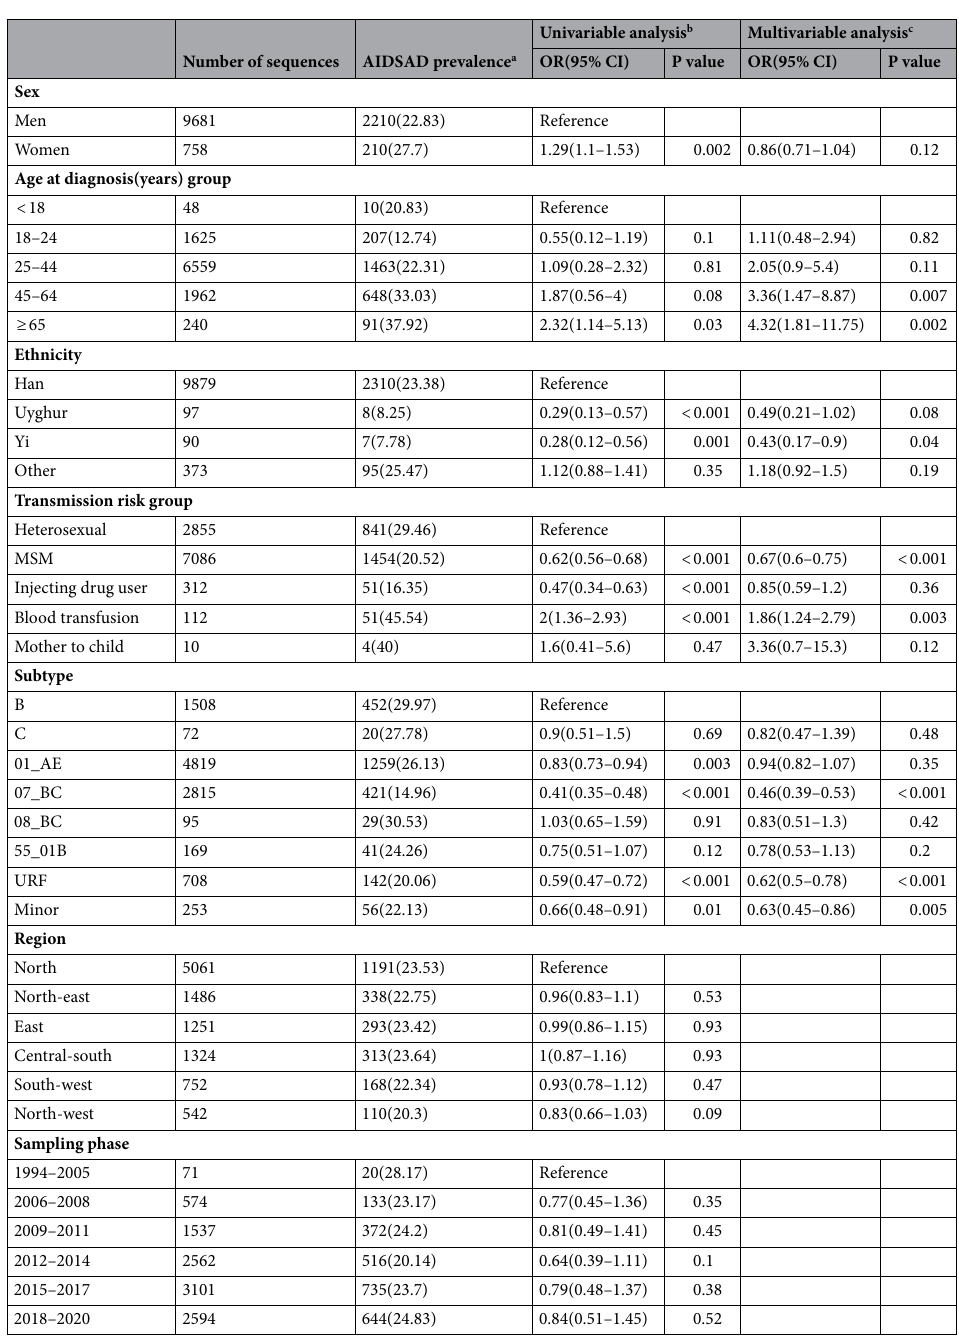
Table 3. Risk factors for slower progression to AIDSAD in Chinese patients. AIDSAD, AIDS at diagnose; OR, odds ratio; MSM, men who have sex with men; URF, unique recombinant form; North, Beijing, Tianjin, Hebei, Shanxi, and Inner Mongolia. North-east, Liaoning, Jilin, and Heilongjiang. East, Shanghai, Jiangsu, Zhejiang, Anhui, Fujian, Jiangxi, and Shandong. Central- south, Henan, Hubei, Hunan, Guangdong, Guangxi, and Hainan. South-west, Chongqing, Sichuan, Guizhou, Yunnan, and Tibet. North-west, Shann’xi, Gansu, Qinghai, Ningxia, and Sinkiang. Minor, A1, D, F1, G, H, CRF02_AG, CRF03_AB, CRF06_cpx, CRF15_01B, CRF18_